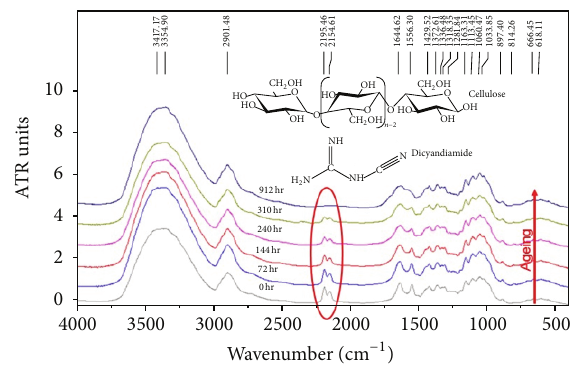
Figure 1: FTIR spectra of kraft paper samples with different ageing time.